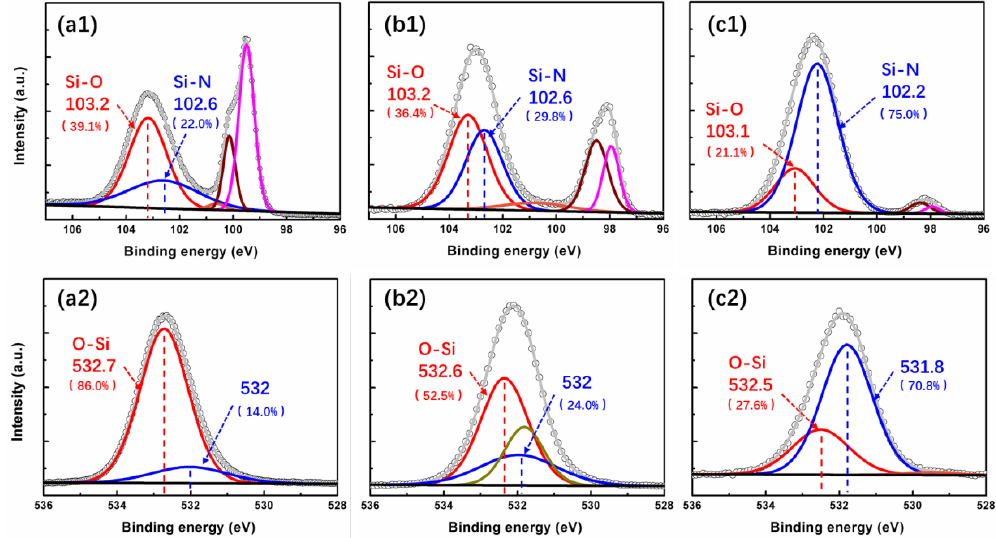
Figure 6. XPS analysis of SiON-1 ( a1 , a2 ), SiON-2 ( b1 , b2 ), and SiON-3 ( c1 , c2 ) sample on ( a1 , b1 , c1 ) Si 2p spectra and ( a2 , b2 , c2 ) O 1s spectra.